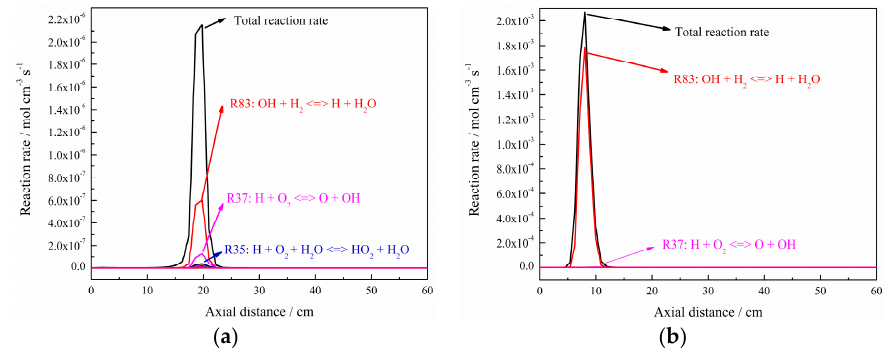
Figure 10. Comparison of typical elementary reaction exothermic reaction rates of biogas flame along the centerline at H 2 addition ratio of 0% ( a ) and 50% ( b ).